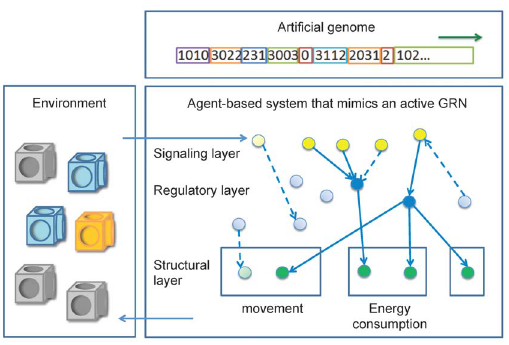
Figure 1. Overview of the GRN-based controller as implement- ed in the current study. The GRN-based controller actually consists of two separate layers. First, an artificial genome (AG) (top panel) encodes the full (core) regulatory network (lower panel, all nodes and edges), i.e. all potential interactions that can take place between signalling (yellow), regulatory (blue) and structural genes (green ‘nodes’). Evolutionary forces act at the level of this genome. Second, an agent-based layer (lower panel) that corresponds to the ‘activated’ regulatory network (colored nodes and full lines). The agent based layer mimics the translation of the core regulatory network into an activated network, following the rules embedded in the AG. Agents thus correspond to activated genes. The agent-based layer constitutes the active controller of the system and drives the behaviour of the robots (left panel). Key to our approach is the condition-dependent activation of the core genome encoded by the AG into an activated network modelled by the agent based layer resulting in the fact that only the translated part of the core network will affect the robots behaviour.